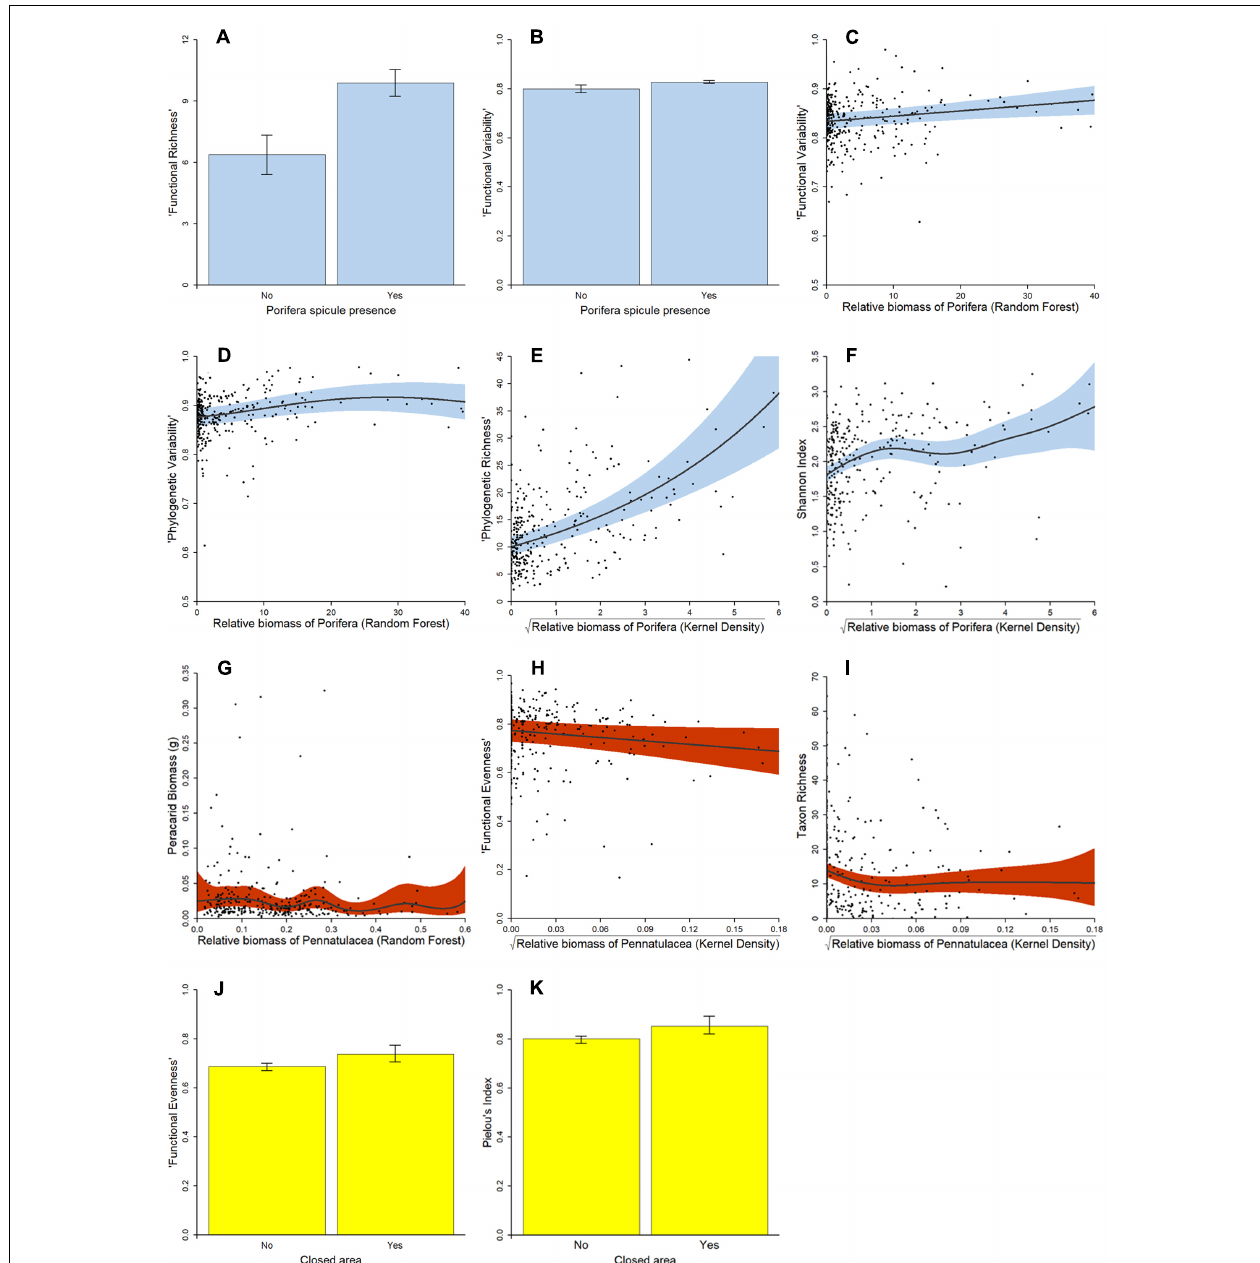
FIGURE 3 | Partial relationship between VME presence at sampling locations ( n = 312) in the NW Atlantic Ocean, and metrics of peracarid crustacean biodiversity. Solid lines are smoothed lines of best fit as determined by Generalised Additive Modelling. Surrounding bands are 95% confidence intervals. (A) siliceous poriferan spicule presence (blue)/“Functional Richness”; (B) siliceous poriferan spicule presence (blue)/“Functional Variability”; (C) relative biomass of Porifera (random forest model) (blue)/“Functional Variability”; (D) relative biomass of Porifera (random forest model) (blue)/“Phylogenetic Variability”; (E) relative biomass of Porifera (kernel √ √ density estimation, transformed) (blue)/Shannon Index; (F) relative biomass of Porifera (kernel density estimation, transformed) (blue)/“Phylogenetic Richness”; √ transformed) (G) relative biomass of Pennatulacea (random forest model) (red)/biomass; (H) relative biomass of Pennatulacea (kernel density estimation, √ (red)/taxon richness; (I) relative biomass of Pennatulacea (kernel density estimation, transformed) (red)/“Functional Evenness”; (J) sample collected from area subject to NAFO VME closure (yellow)/“Functional Evenness”; (K) sample collected from area subject to NAFO VME closure (yellow)/Pielou’s Index.